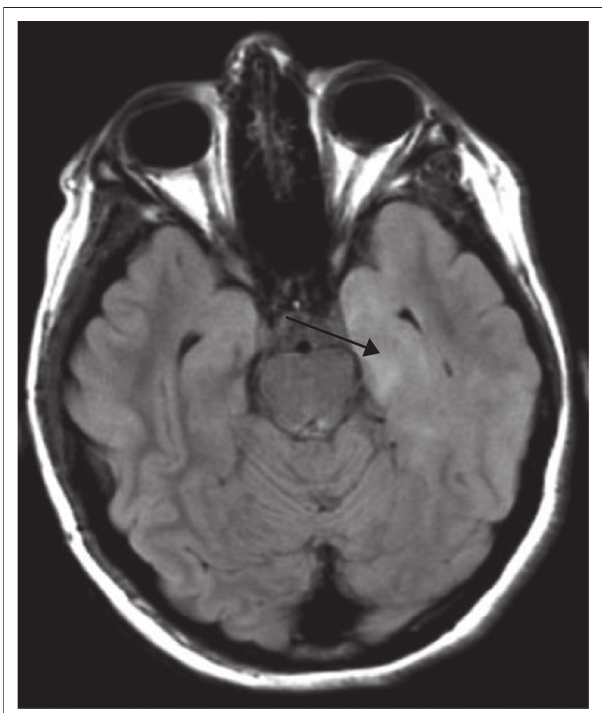
FIGURE 3: Nine-year-old child with a year-long history of refractory generalised tonic-clonic seizures after cigarette olfaction aura. Axial FLAIR shows enlargement of the left temporal lobe compared with the right; abnormal signal intensity within the thickened cortex; and loss of gray and white matter differentiation (arrow). Pathology of the resected specimen revealed focal cortical dysplasia type 1 with hippocampal sclerosis, consistent with Type IIIA FCD as per the latest FCD